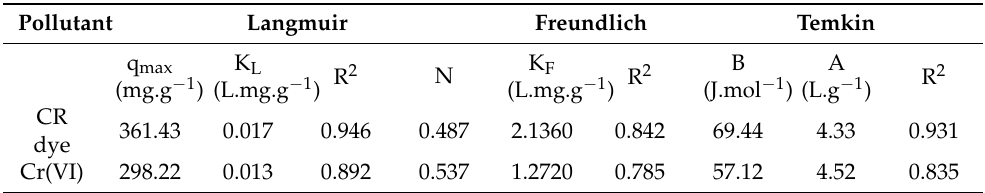
Table 1. The calculated Langmuir and Freundlich isotherm parameters for the removal of Cr(VI) and CR dye over PPy/Fe 3 O 4 /SiO 2 nanocomposite. Pollutant Langmuir Freundlich Temkin q